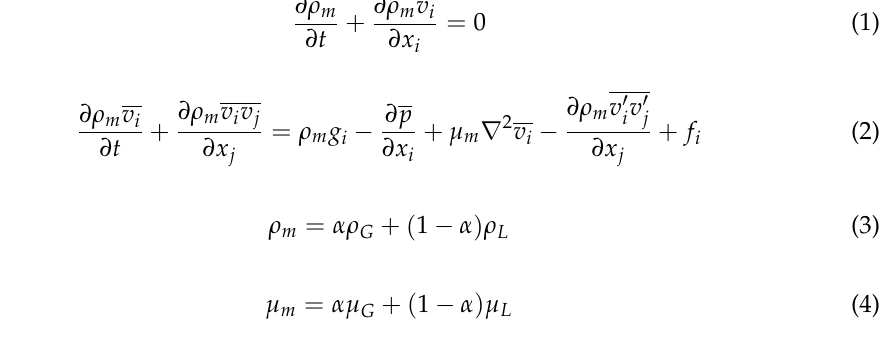
Figure 3. The fundamental modal shapes in both in-plane and out-of-plane directions obtained via modal analysis, where f x1 , f z1 and f y1 denote the fundamental natural frequencies in x, z and y direc- tions, respectively.